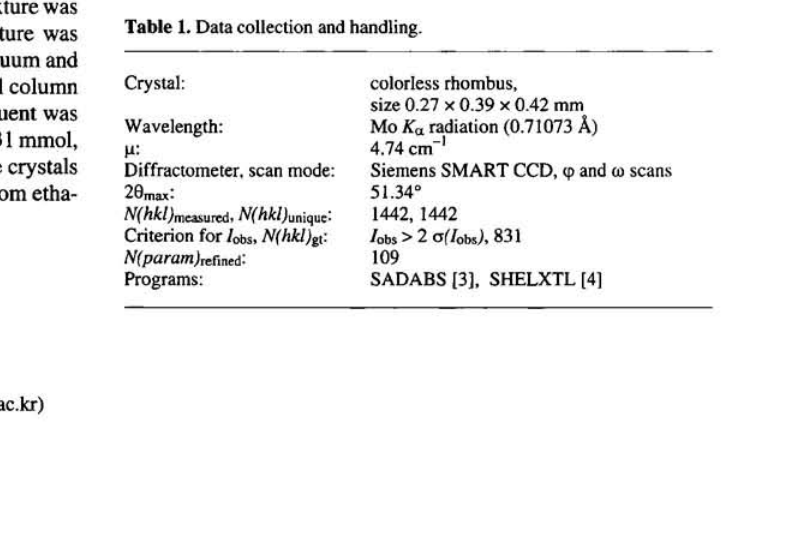
Table 1. Data collection and